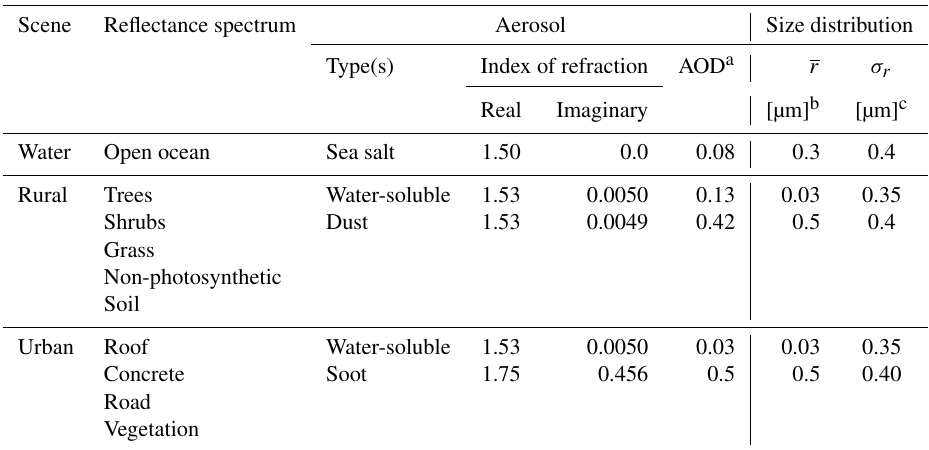
Figure 2. Basic surface reflectance spectra used in radiative transfer simulations: (a) water, (b) vegetation, and (c) urban. (d) Spectra in the NO 2 retrieval spectral range. Table 1. UNL-VRTM